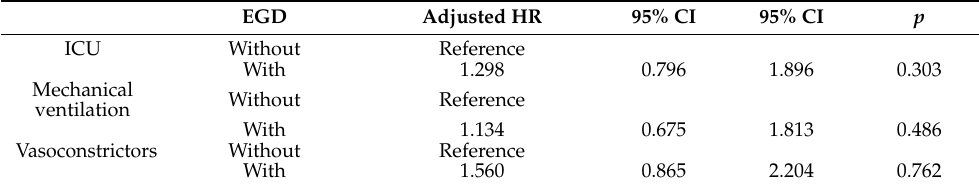
Table 4. Other covariates of outcomes in 1 month by using multivariable Cox regression. EGD